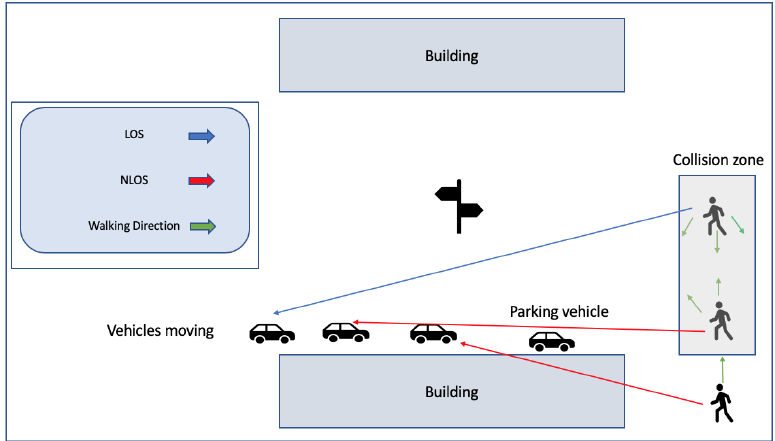
Figure 4. WiFi dangerous scenarios in Reference